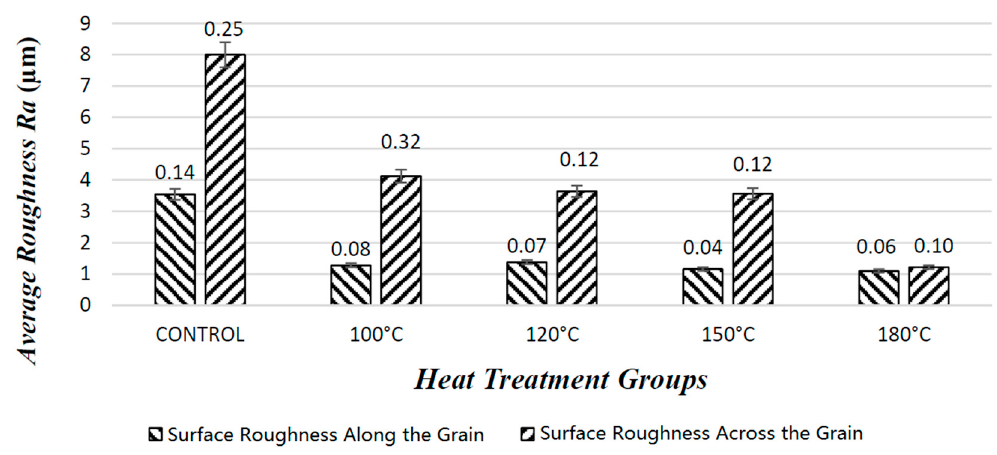
Figure 10. Surface roughness values of the samples after densification process.